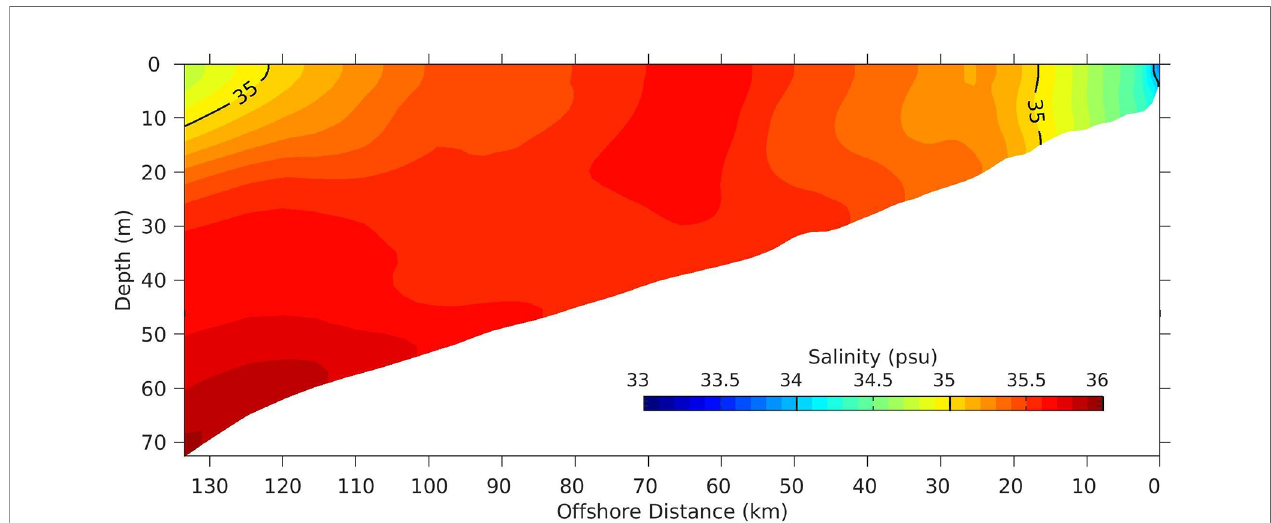
FIGURE 2 | A typical summer season salinity section sampled offshore from Sarasota, FL., as simulated using the West Florida Coastal Ocean Model